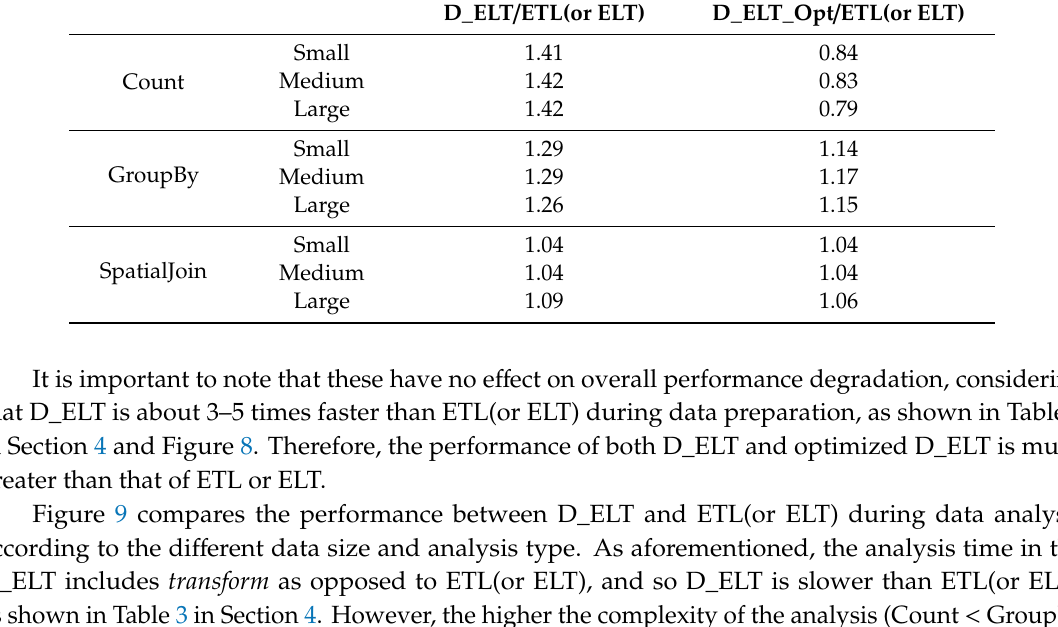
Table 4. Performance comparison: D_ELT / ETL(or ELT) and optimized D_ELT / ETL(or ELT).